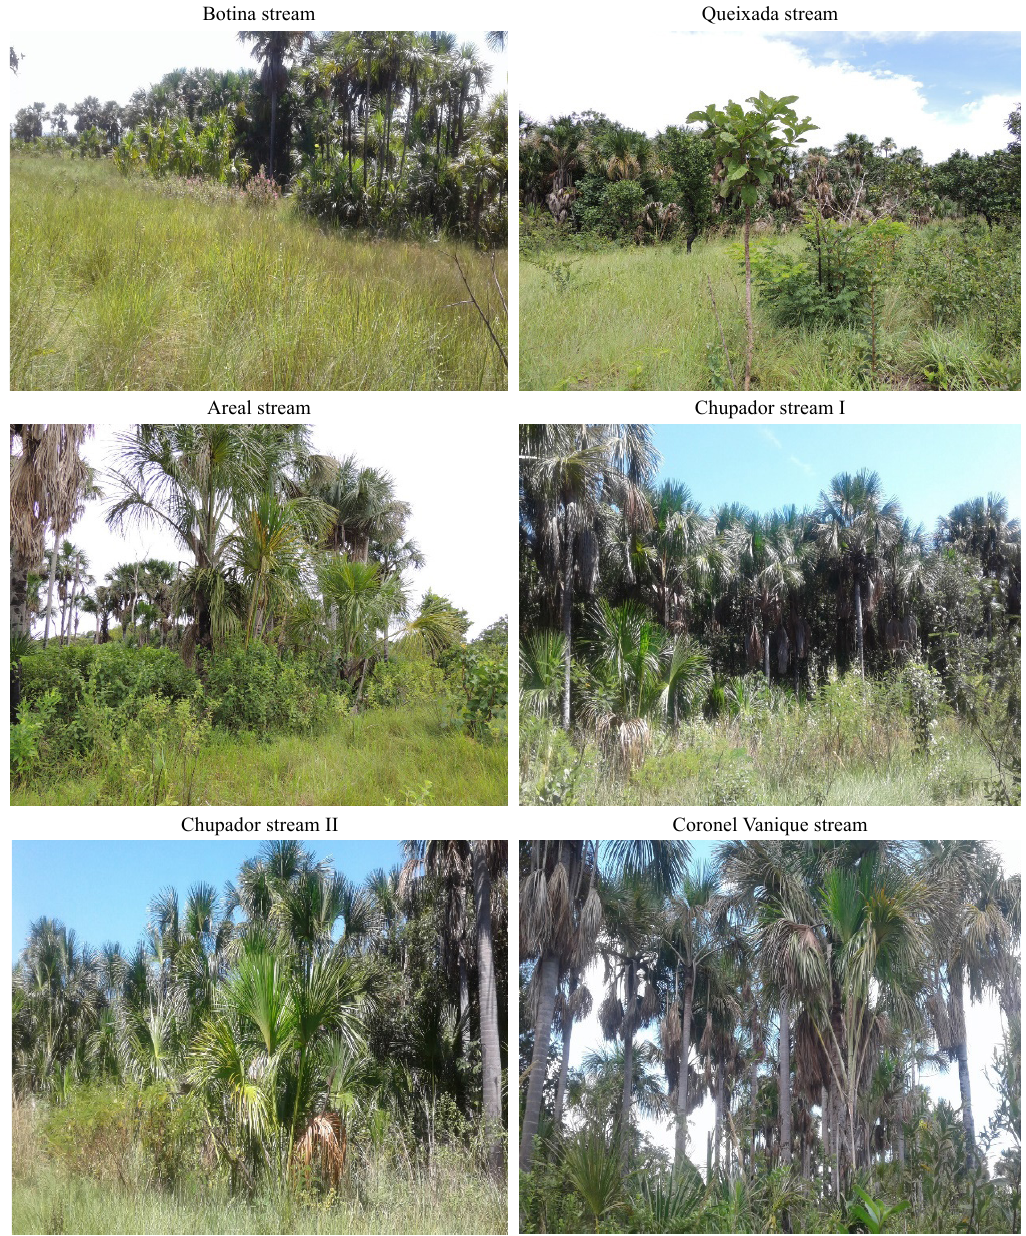
Fig 2. Landscape features of the six study Veredas in the Cerrado–Amazon transition zone in the municipality of Nova Xavantina, in Mato Grosso state, central Brazil. Botina stream, Chupador stream I and II, Areal stream, Coronel Vanique stream, and Queixada